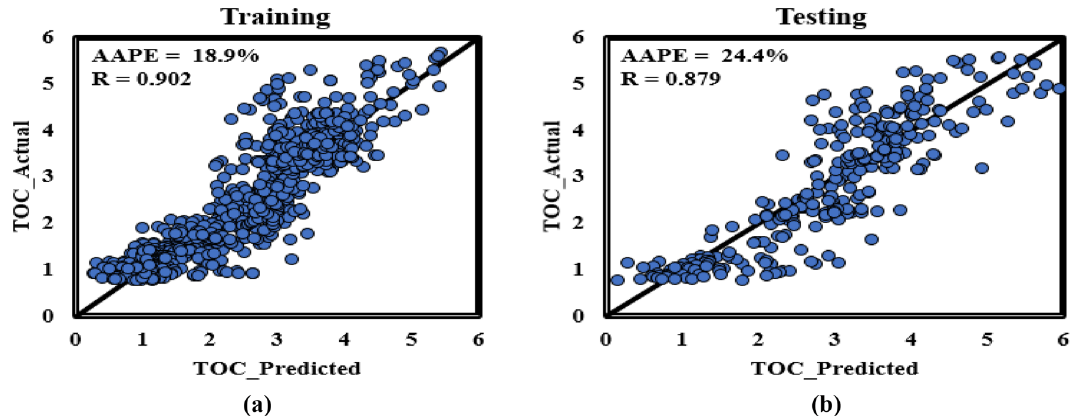
Fig. 7 Cross-plots of the FN-predicted and measured TOC for a the training and b the testing datasets